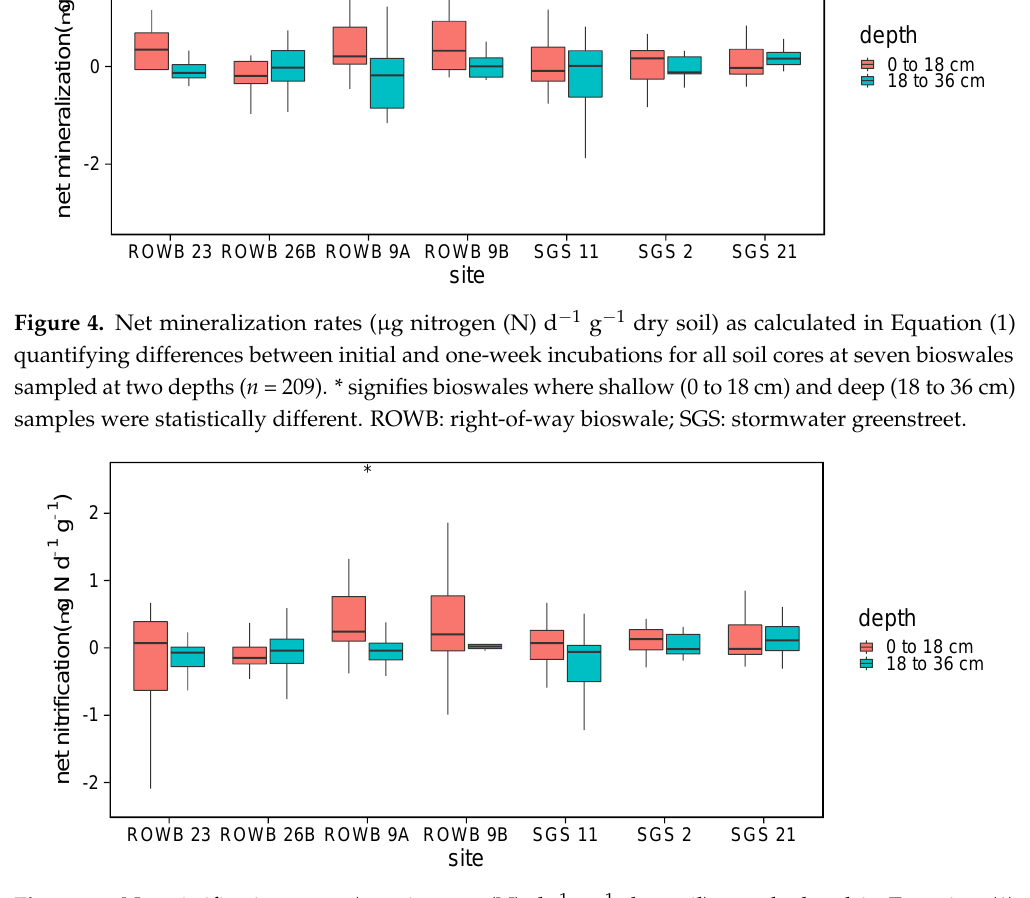
Figure 5. Net nitrification rates ( µ g nitrogen (N) d − 1 g − 1 dry soil) as calculated in Equation (1) quantifying differences between initial and one-week incubations for all soil cores at seven bioswales sampled at two depths ( n = 209). * signifies bioswales where shallow (0 to 18 cm) and deep (18 to 36 cm) samples were statistically different. ROWB: right-of-way bioswale; SGS: stormwater greenstreet.